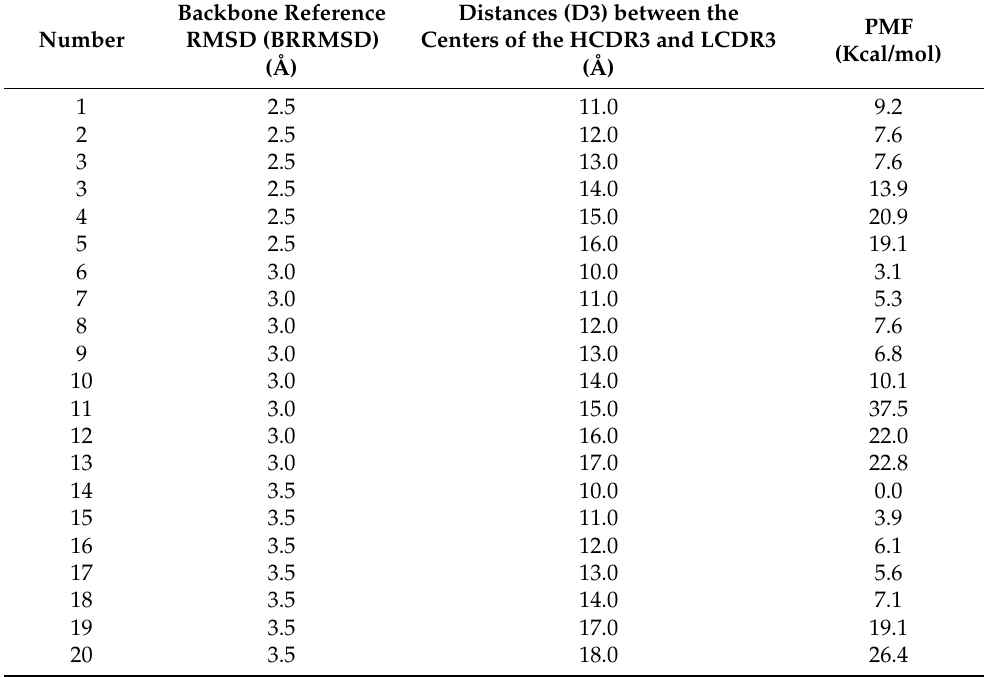
Table 2. Possible antibody conformation states based on GaMD/CpHMD simulations of W1-Humira at pH 7.4.